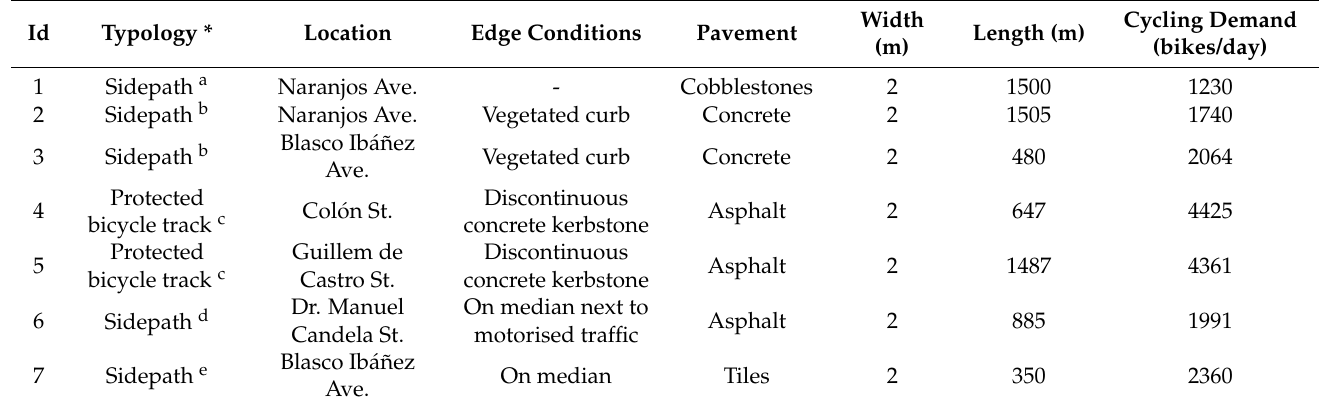
Table 1. Selected bicycle tracks.